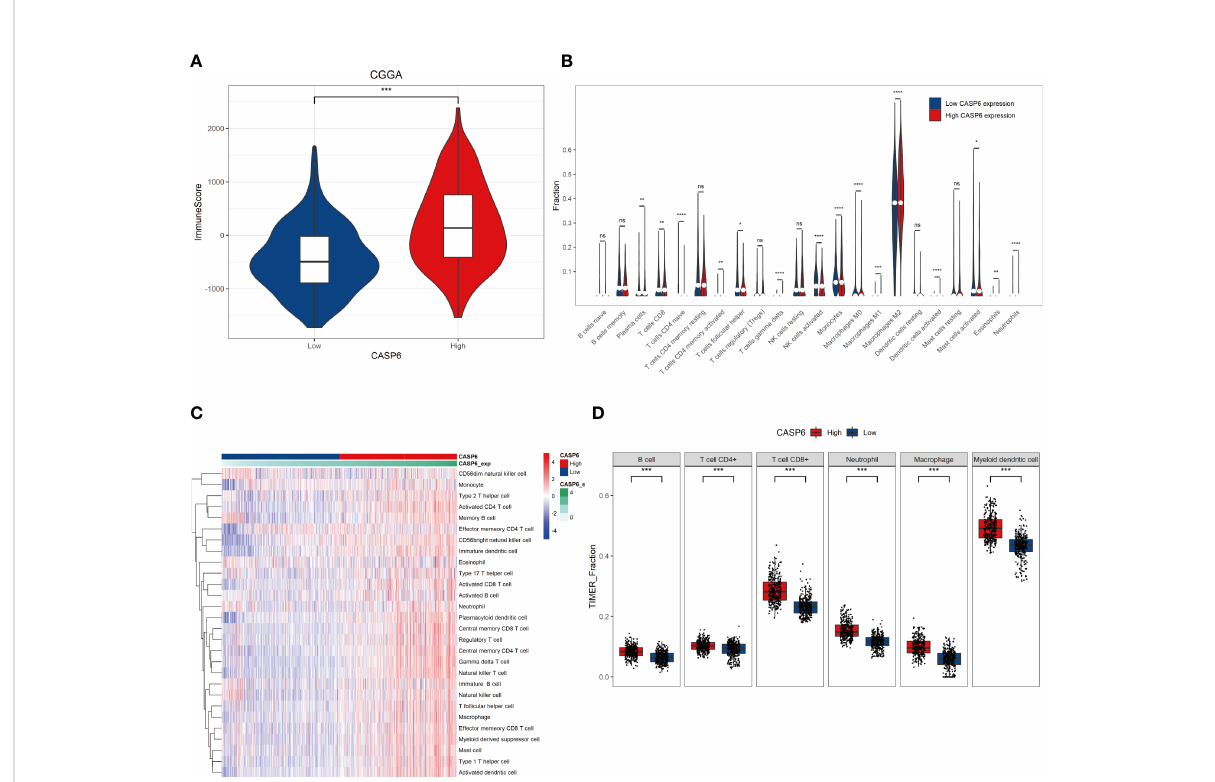
FIGURE 4 Relationships with CASP6 in the tumor immune microenvironment from the CGGA database. (A) Correlation analysis of the ImmuneScore and CASP6 levels. (B) The levels of in fi ltration of 22 types of immune cells in the low and high CASP6 expression groups. (C) Results of ssGSEA analysis of CASP6 in the CGGA database. (D) Results of TIMER analysis of CASP6 in the CGGA database. * P < 0.05, ** P < 0.01, *** P < 0.001, **** P < 0.0001. ns, no signi fi cance